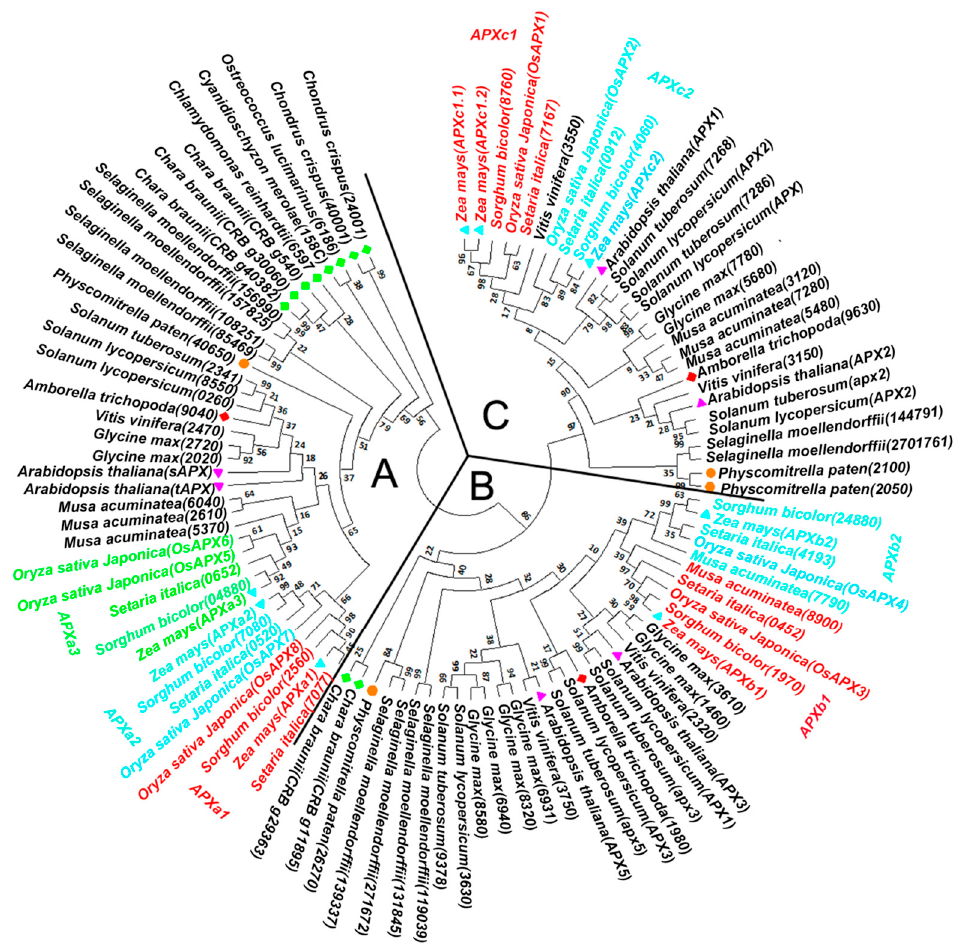
Figure 1. A phylogenetic tree of ascorbate peroxidase ( APX ) genes. The tree was constructed by the maximum likelihood (ML) method using MEGA6 with 1000 bootstrap replications and the Dayhoff substitution model. The gap/missing data treatment is partial deletion, and the site coverage cutoff (%) is 70. Numbers on branches indicate bootstrap support values. The protein sequences encoded by APX genes in the phylogenetic tree are shown in Table S1. A, B, and C in the figure represent the gene groups of classes A, B, and C, respectively. The genes from A. thaliana , maize, Amborella trichopoda , algae, and moss are labeled by pink triangles, blue triangles, red diamonds, green diamonds, and orange dots, respectively.